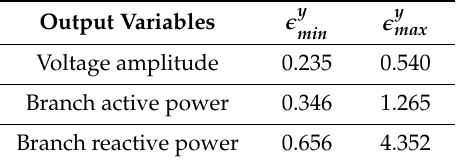
Table 3. ARMS indicator of Node 30 output variable.